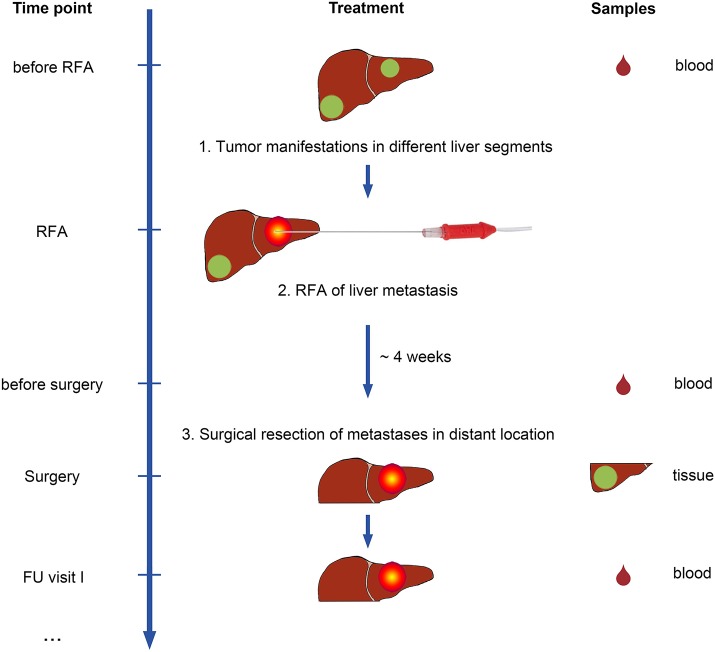
Study design of the IRISS trial. Patients with metastasized colorectal cancer (mCRC) and tumor manifestations in different liver segments were included in the study. Patients underwent RFA treatment for one malignant liver lesion first. After ~4 weeks, a second lesion was surgically removed. As a control group, mCRC patients were included who underwent surgical resection only. Blood samples (drops, right) were collected at predefined time points before initiation of treatment and during follow-up visits. Tumor and non-malignant liver (NML) tissue was obtained from surgical specimens for analysis.